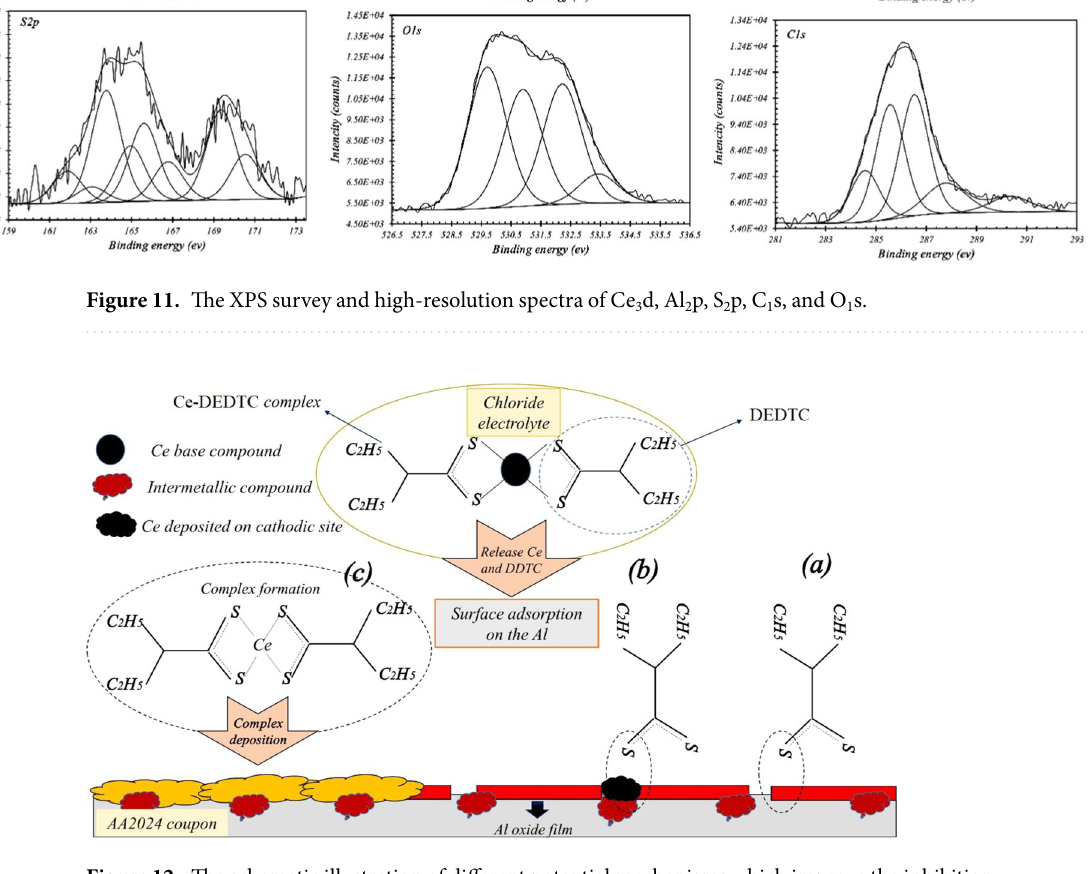
Figure 12. The schematic illustration of different potential mechanisms which improve the inhibition properties of the AA2024-T3 in 3.5 wt.% NaCl electrolyte in the existence of Ce-DEDTC